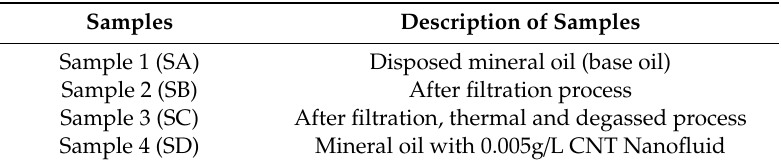
Figure 4. Preparation process of MWCNT nanofluid.